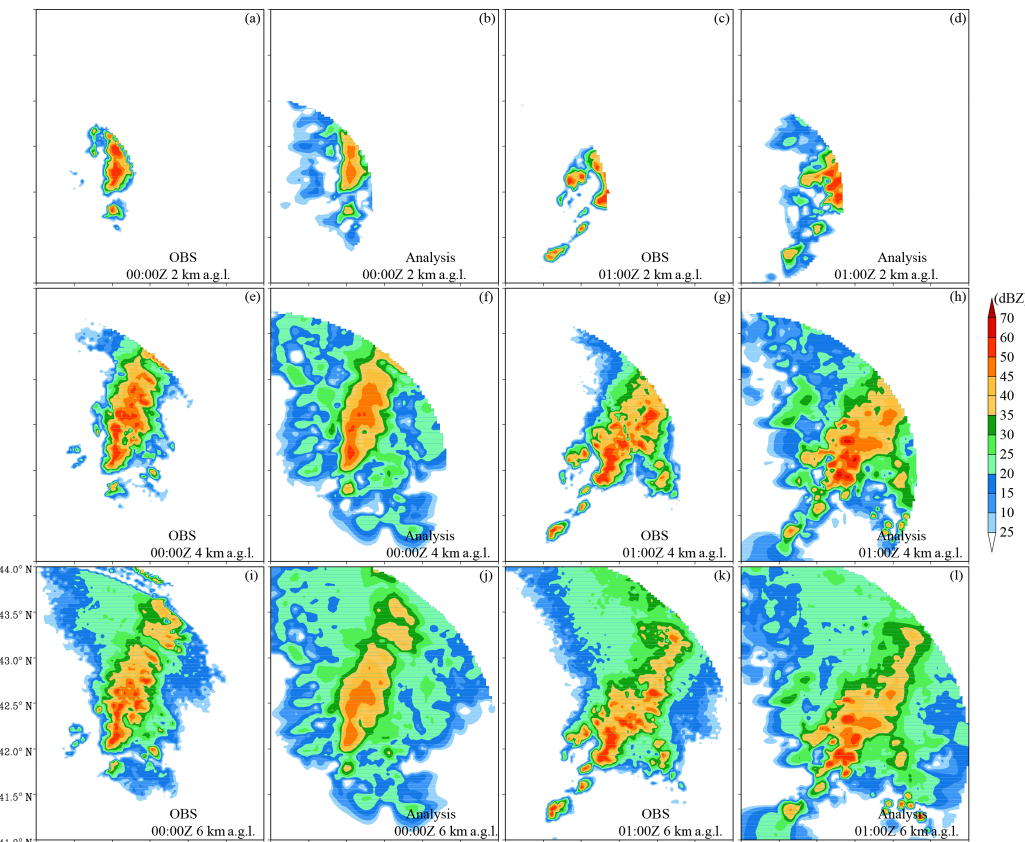
Figure 7. The (a, e, i, c, g, k) observed (KLNX) and (b, f, j, d, h, l) analysis reflectivities at (a–d) 2km, (e–h) 4km, and (i–l) 6kma.g.l. at (a, e, i, b, f, j) 00:00Z and (c, g, k, d, h, l) 01:00Z in